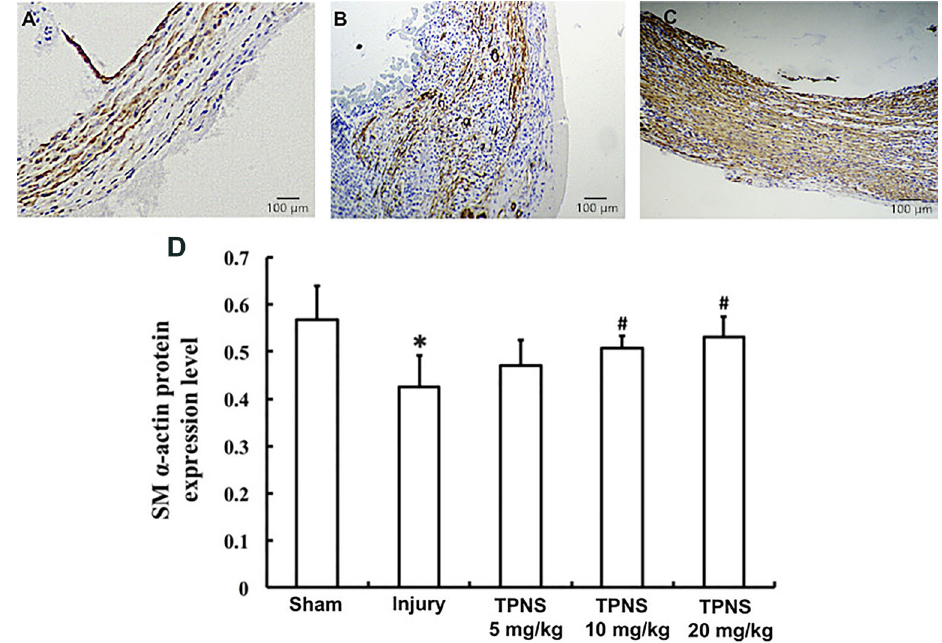
Figure 3. Effects of total Panax notoginseng saponin (TPNS) on smooth muscle (SM) a -actin protein in balloon-injured carotid artery walls. A , B , and C show representative sections (original magni fi cation 100 (cid:1) , bar: 100 m m) of carotid arteries with SM a -actin protein immunohistochemistry staining in the sham group, injury group, and high dose (20 mg (cid:3) kg – 1 (cid:3) day – 1 ) TPNS-treatment group, respectively. The total SM a -actin protein expression levels in the combined neointimal area (NIA) and media area (MA) layers in the sham group, injury group, and low, medium, and high TPNS-treatment groups (5, 10, and 20 mg (cid:3) kg – 1 (cid:3) day – 1 ) are quantitatively shown in D . Data are reported as means ± SE of 10 rats per group. *P o 0.05 compared to Sham; # P o 0.05 compared to injury (ANOVA and Tukey ’ s HSD post hoc